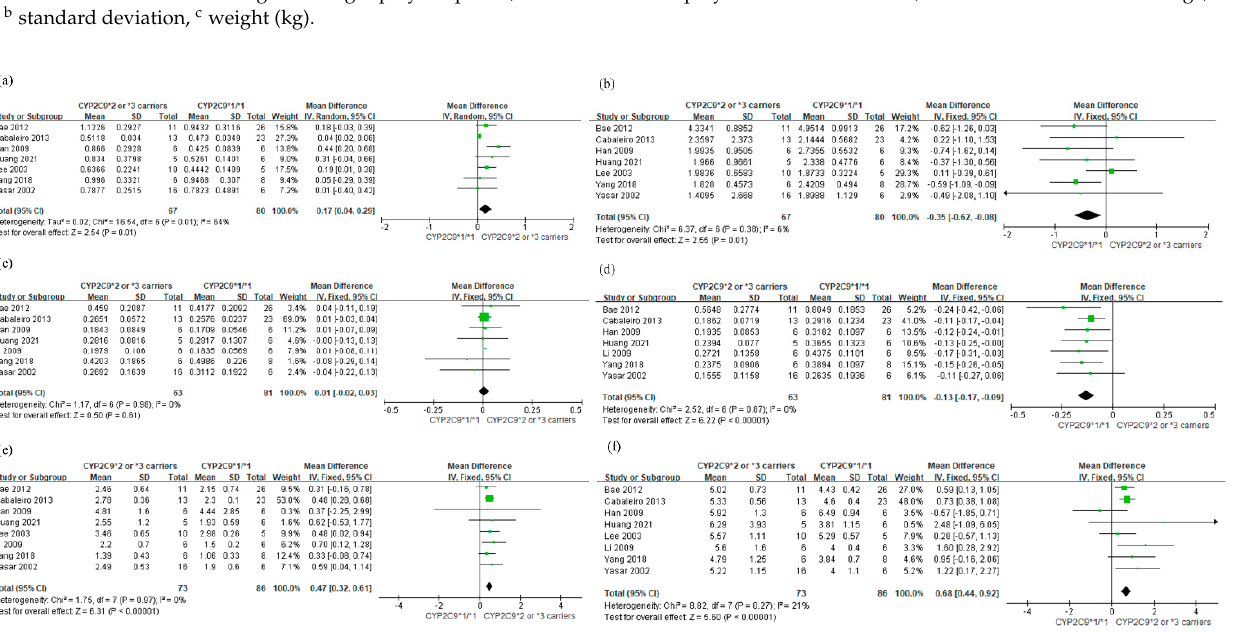
Figure 1. Flow diagram of study selection.